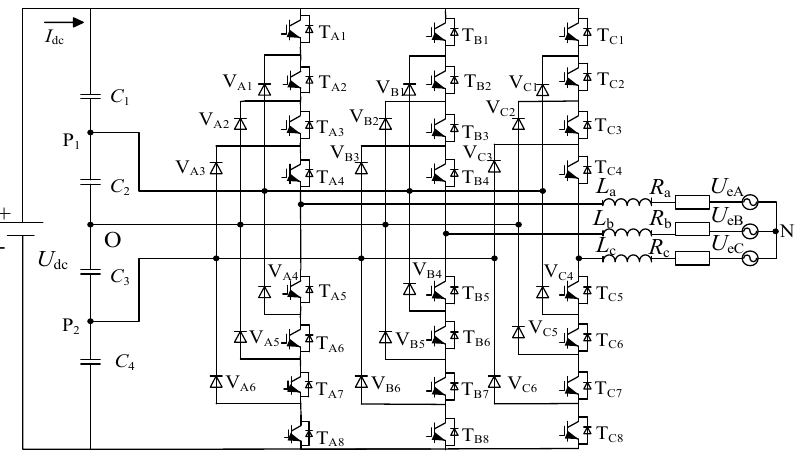
Figure 1. The topology of the diode-clamped five-level inverter.